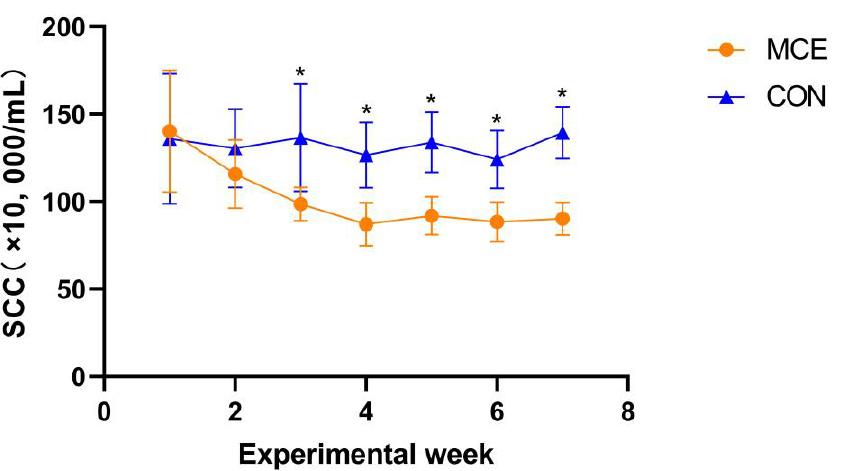
Figure 1. Change in average milk yield throughout the study period in dairy goats. CON — fed a basal diet, MCE — fed a basal diet supplemented with 400 mg/kg macleaya cordata extract. Bars in- dicate the standard errors. * Superscripts indicate significant difference ( p < 0.05), while no-sign su- perscripts indicate no significant difference ( p > 0.05).